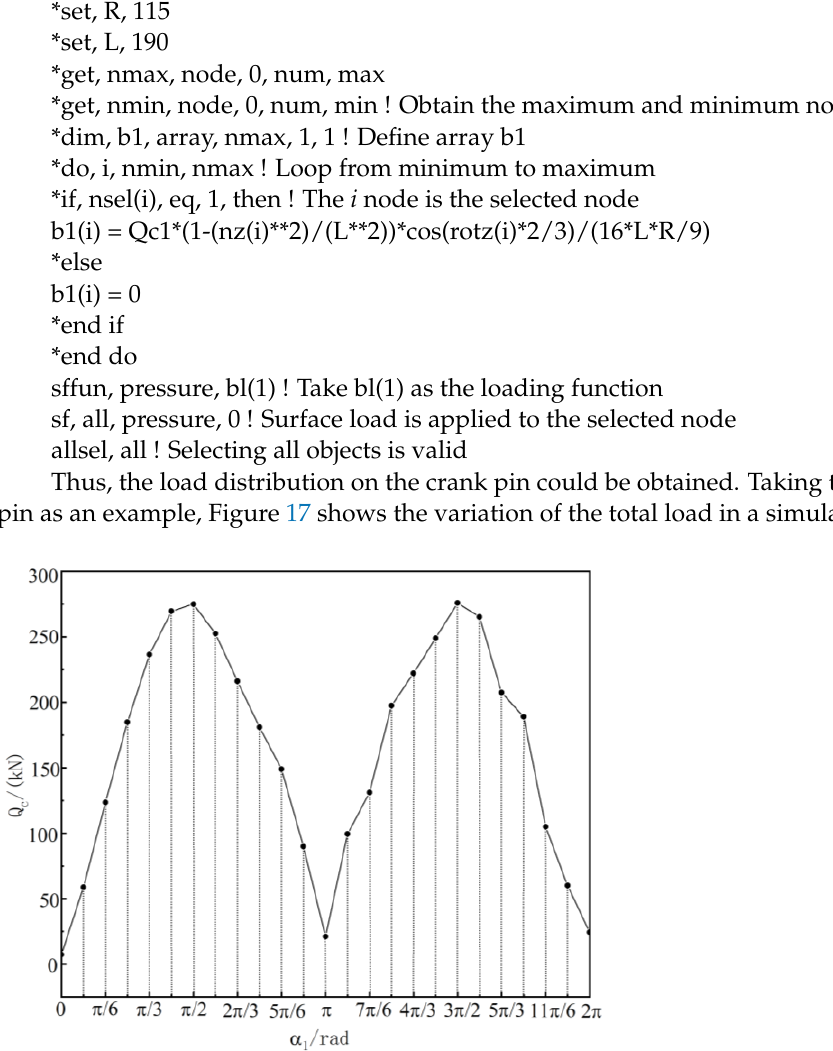
Figure 17. Schematic diagram of the load on the crank pin and the change curve of the first crankshaft angle.